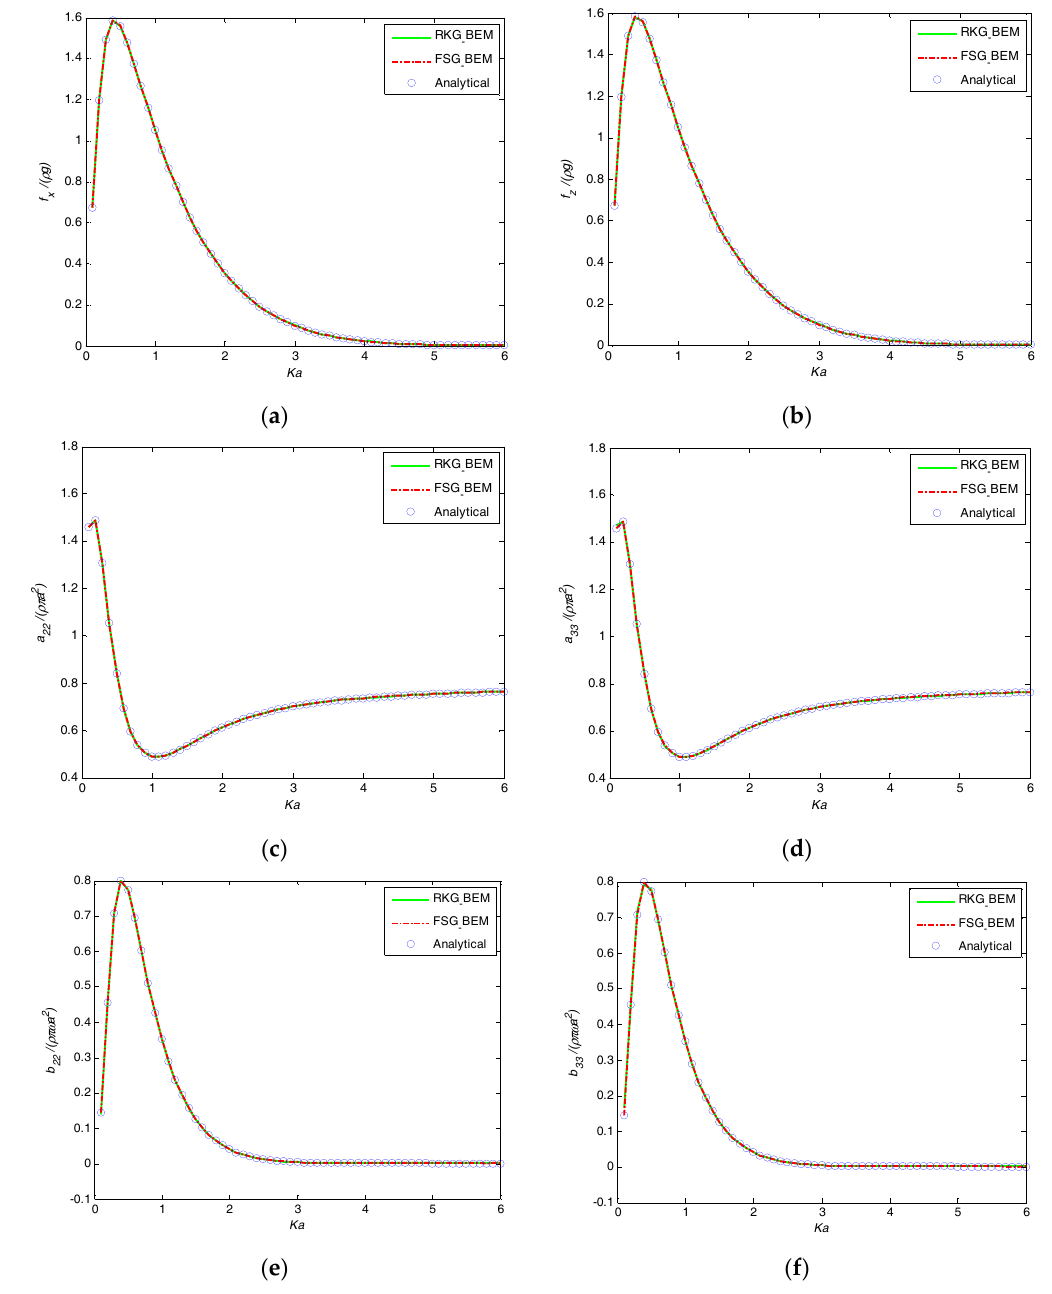
Figure 8. Comparison of hydrodynamic characteristics of a submerged cylinder. For captions of the subplots please refer to Figure 7.